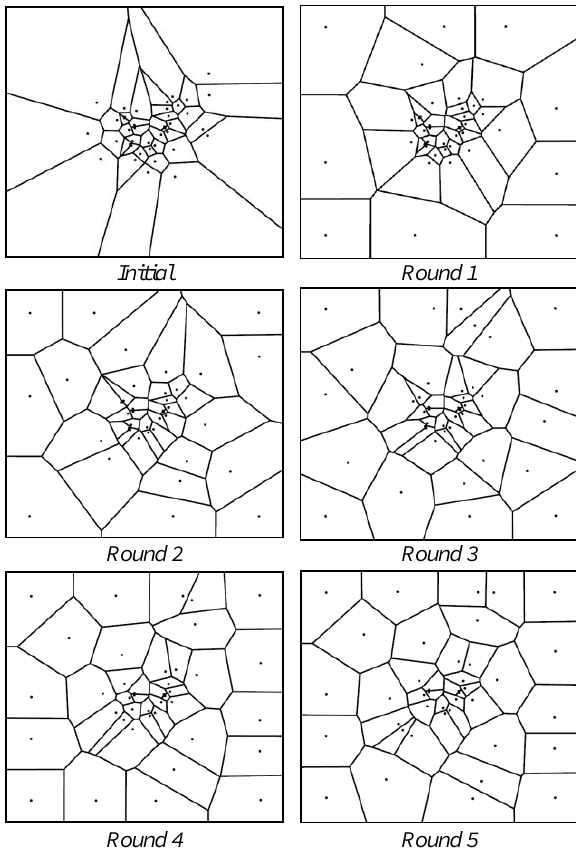
Figure 4. An example of sensor deployment based on the VOR algorithm (Wang et al., 2006)